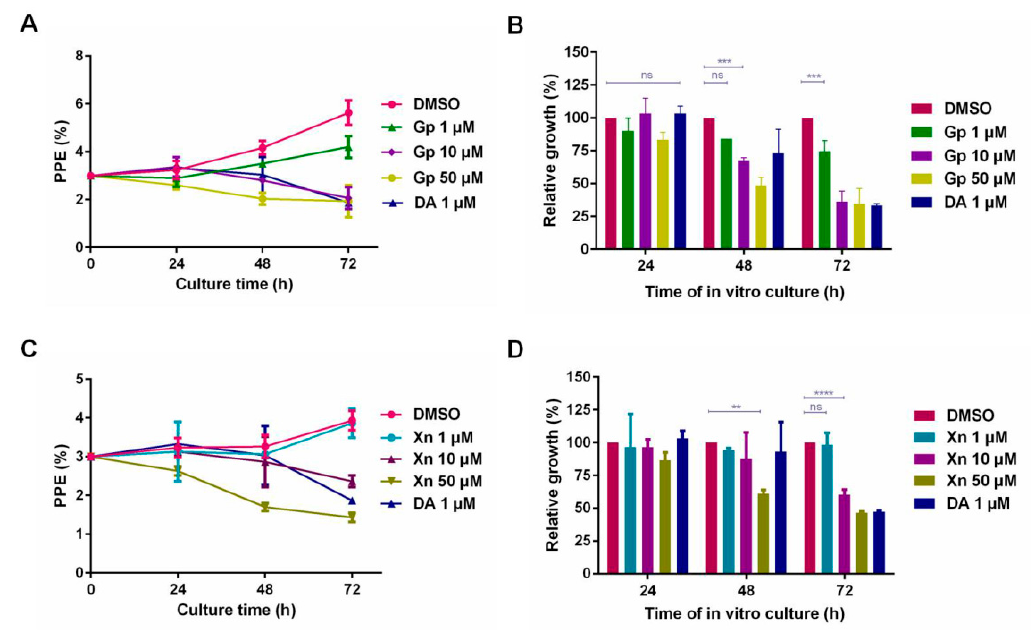
Figure 7. The inhibitory effect of gossypol and xanthohumol on the in vitro culture of B. microti . The parasitemia for treatment with different concentrations of gossypol ( A , B ) as well as different concentrations of xanthohumol ( C , D ). (“ns”: no significance, **** p < 0.0001, *** p < 0.001 and ** p < 0.01).